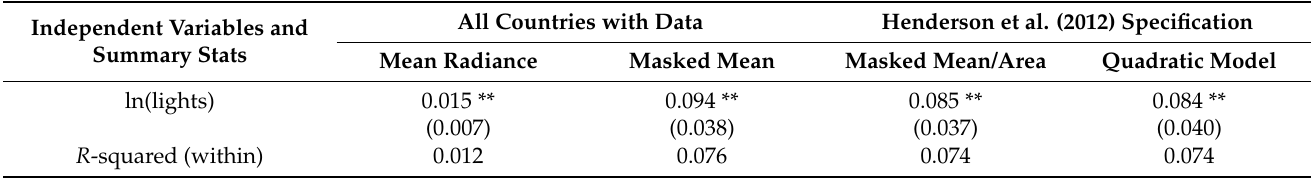
Table 1. Within estimator results for GDP-lights elasticities using V.2 VNL data: country-level 2014 to 2019. Independent Variables and